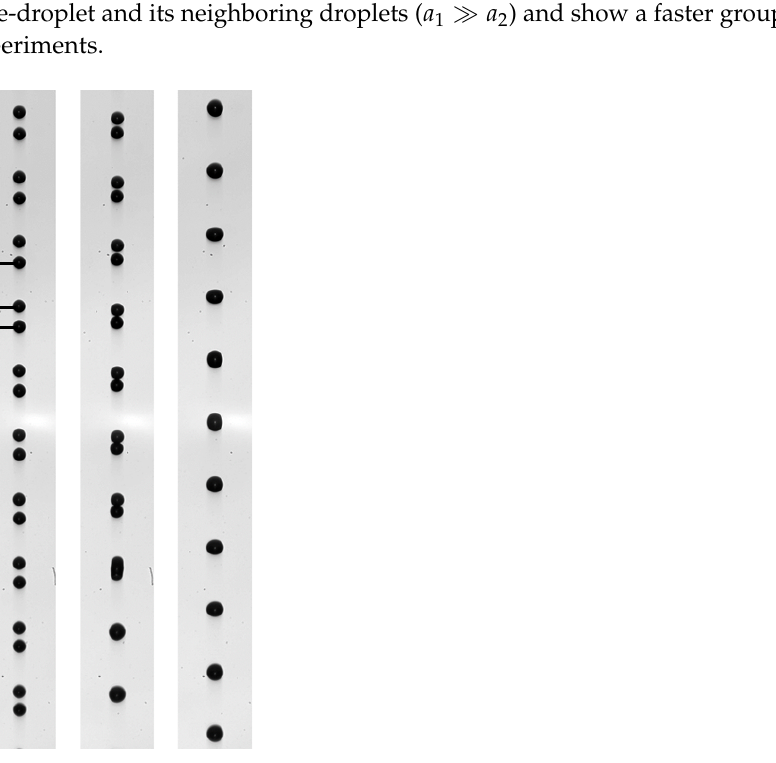
Figure 3. Images showing a train of double-droplet systems falling vertically down under gravity at a time period in the vicinity of t o . The experimental conditions are the same as given in the caption of Figure 2. Each column corresponds to the image taken at a particular distance from the exit of the droplet generator, l ; l increases from left to right and top to bottom. Adapted from